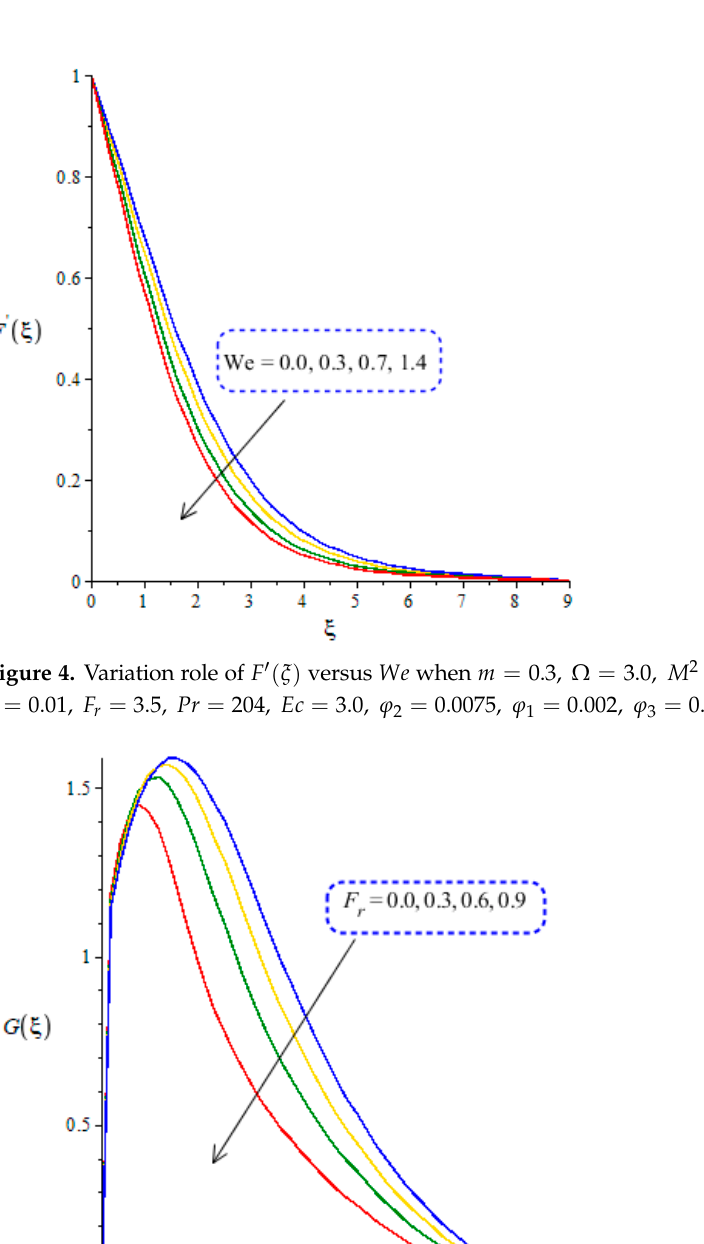
Figure 3. Variation role of −𝐺(𝜉) versus 𝑊𝑒 when 𝑚 = 0.5,Ω = 3.0,𝑀 (cid:2870) = 0.1, 𝛽 (cid:3032) = 0.3,𝛽 (cid:3036) =